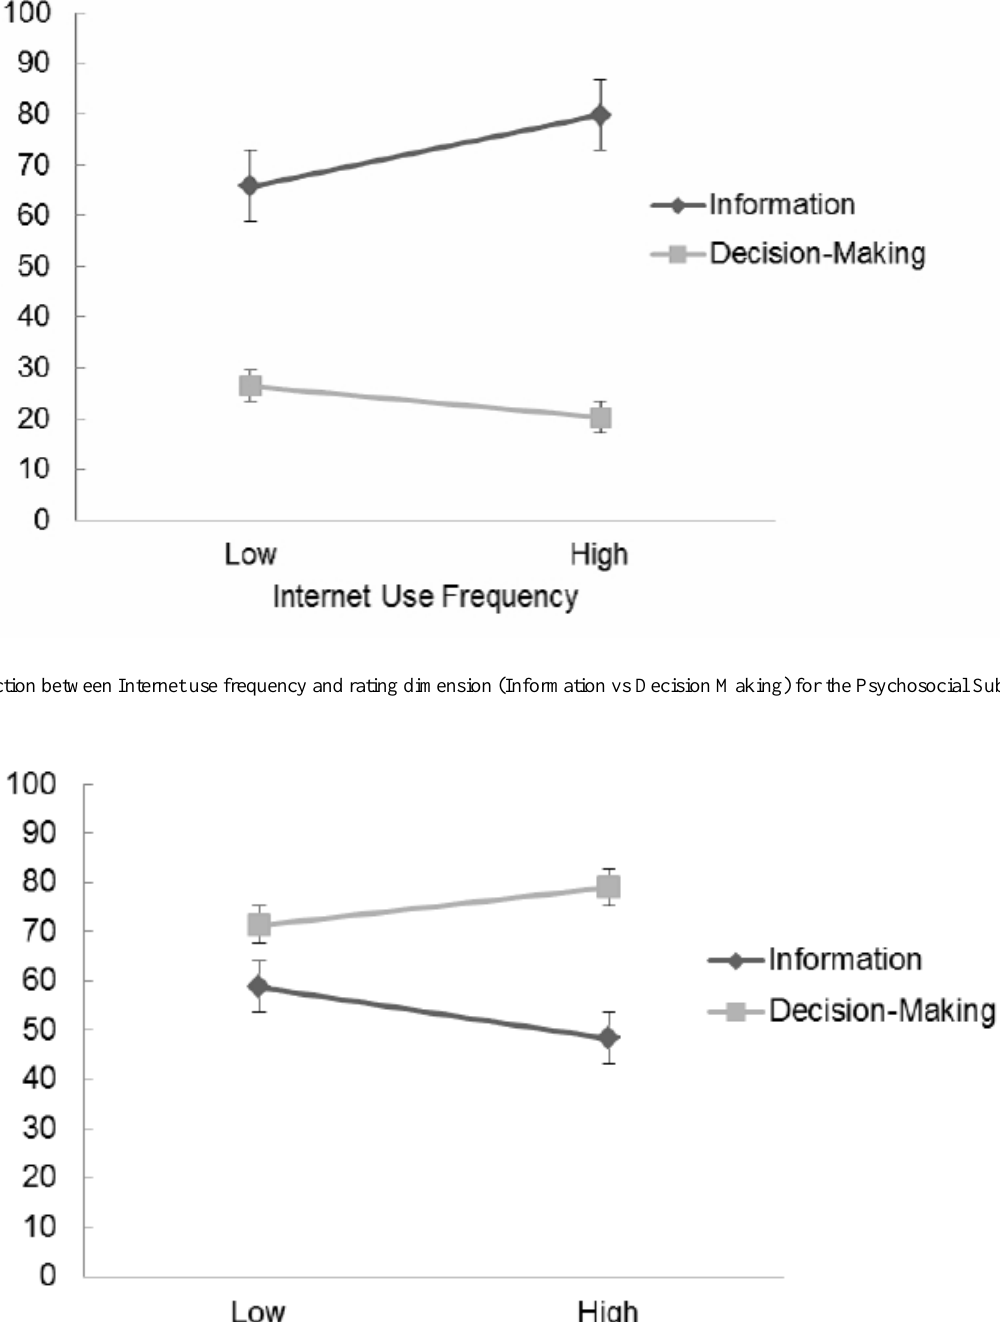
Figure 1. Interaction between Internet use frequency and rating dimension (Information vs Decision Making) for the Diagnosis Subscale.